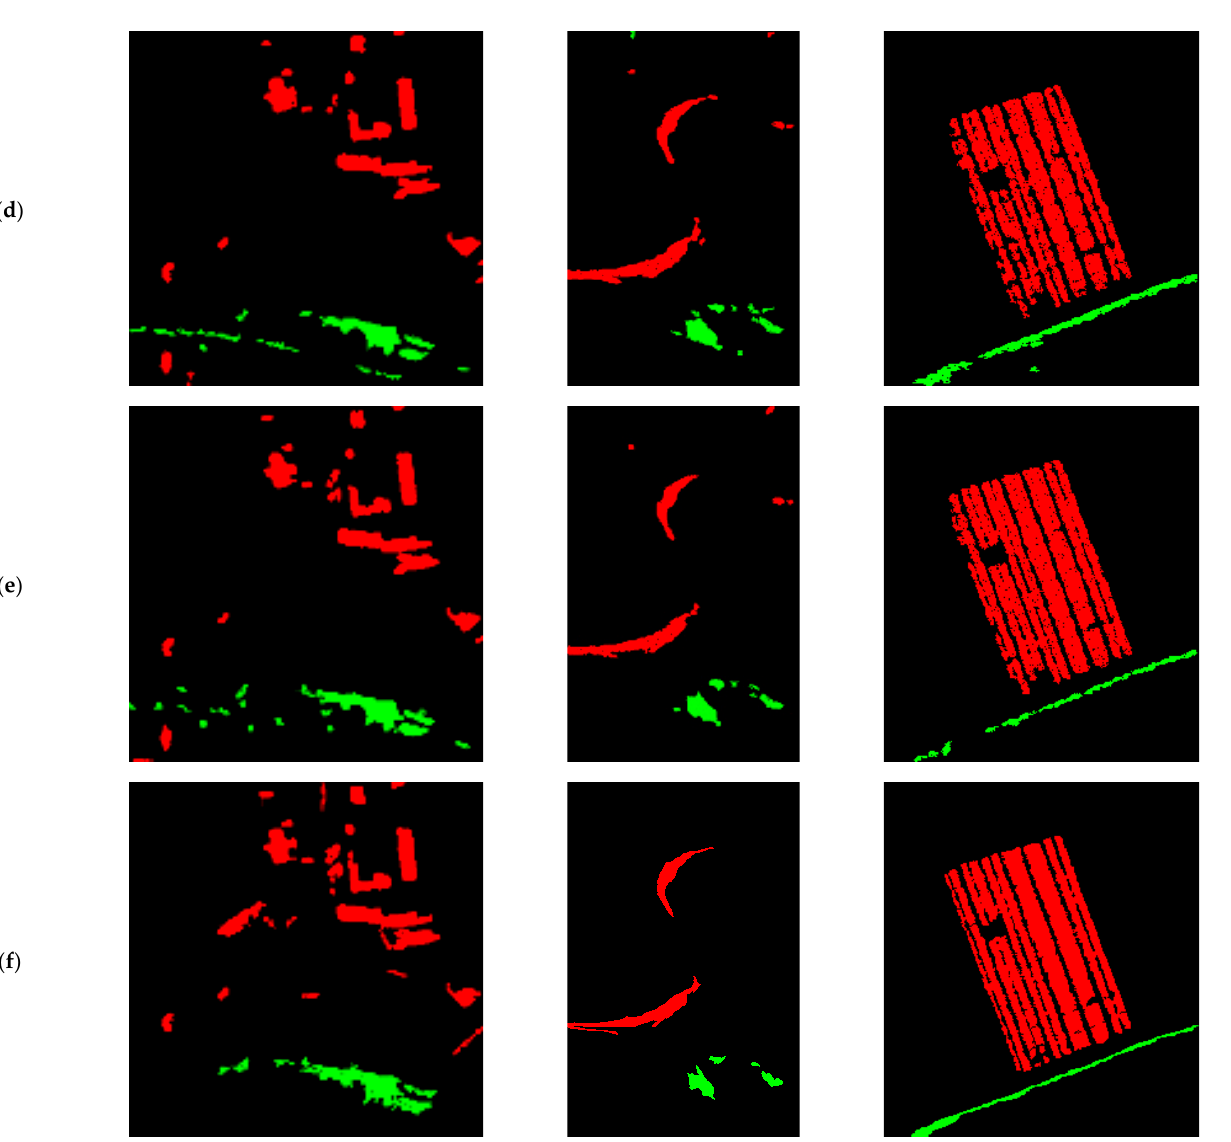
Figure 5. Change recognition results of different methods: ( a ) Results of the CNN; ( b ) results of SqueezeNet; ( c ) results of ShuffleNet; ( d ) results of MobileNet v2; and ( e ) results of LMNet. ( f ) The change recognition reference chart. Red indicates the change type of land to water (LW), green indicates the change type of water to land (WL), and black indicates the unchanged type. Table 3. Change recognition results of different methods on three datasets.